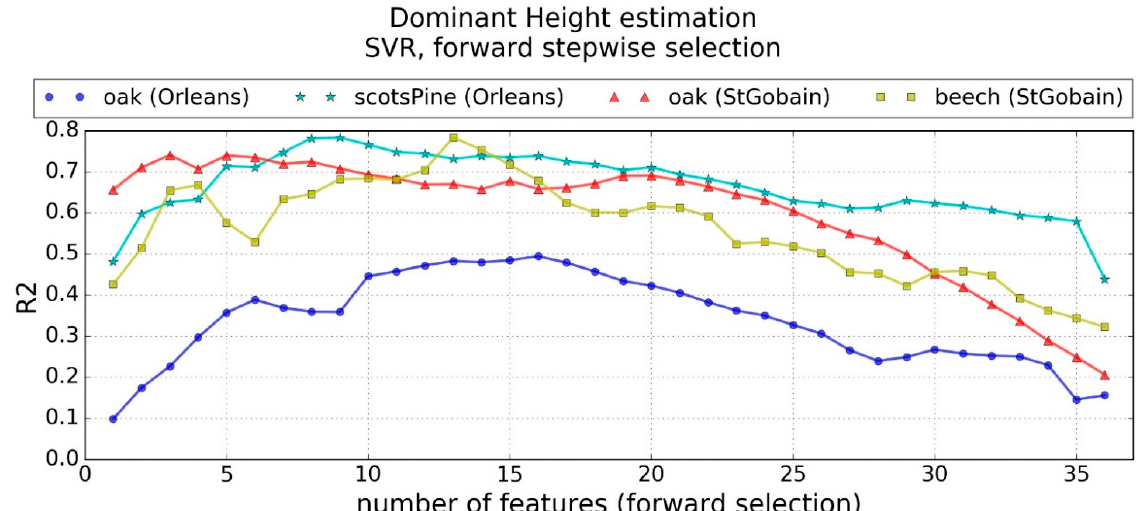
Figure 4. Coefficient of determination (r 2 ) of dominant height estimation (ONF field measurements for model training and validation with a LOO cross-validation), evolution with the number of features selected with a forward stepwise selection.